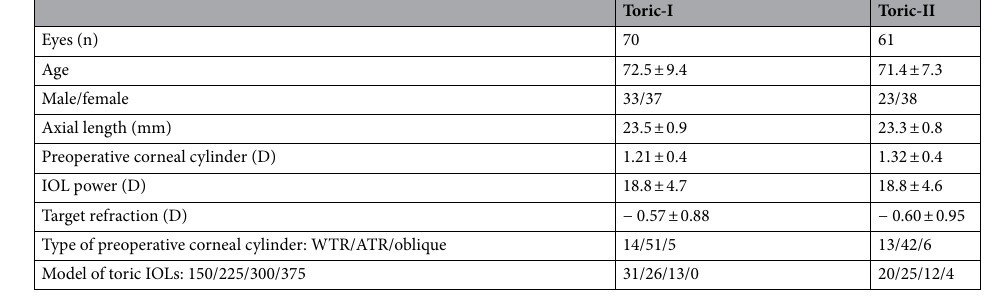
Table 1. Patient characteristics. Mean ± standard deviation; IOL intraocular lens, D diopters, WTR with-the- rule astigmatism (steep corneal cylinder axis was between 60° and 120°), ATR against-the-rule astigmatism